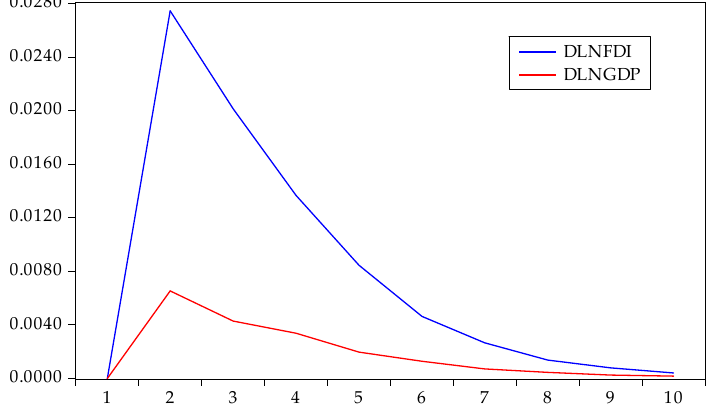
Figure 5. Impulse response of DLNEC to DLNFDI and DLNGDP.